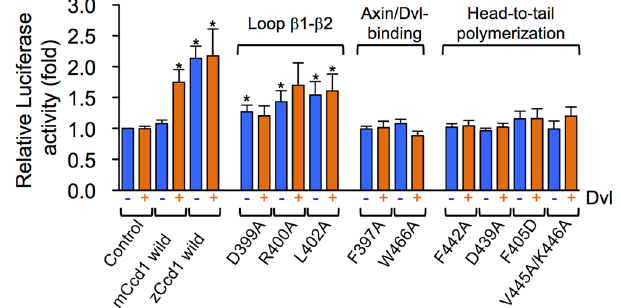
Figure 6. Effect of homopolymerization on mCcd1 signaling activity. TCF-dependent transcriptional activity in HeLa cells transfected with mCcd1 (wild type and mutants) and zCcd1 was analyzed by a luciferase reporter assay. The data are shown as the means ± standard error based on five independent experiments. Asterisks indicate statistical significance compared with negative control in the absence of Dvl (p < 0.05 by Student’s t -